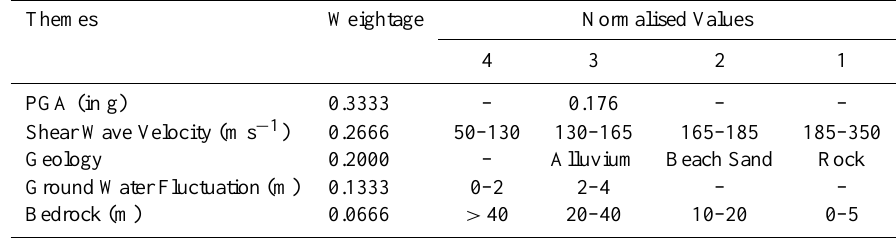
Table 4. Normalised ratings of the thematic